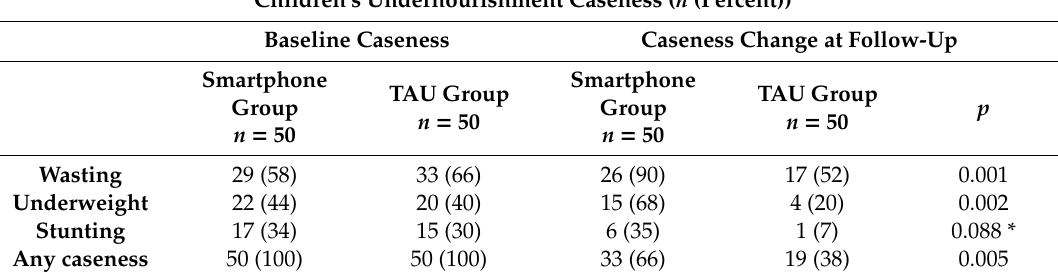
Table 5. Children’s undernourishment caseness (z-score < -2) at baseline measured as wasting (WHZ), underweight (WAZ), and stunting (HAZ), and caseness change at follow-up in smartphone and TAU groups ( n (percent)). p -values indicate di ff erence in caseness change between the study groups. Children’s Undernourishment Caseness ( n (Percent)) Baseline Caseness Caseness Change at Follow-Up Smartphone Smartphone TAU Group TAU Group p Group Group n = 50 n = 50 n = 50 n = 50 Wasting 29 (58) 33 (66) 26 (90) 17 (52) 0.001 Underweight 22 (44) 20 (40) 15 (68) 4 (20) 0.002 Stunting 17 (34) 15 (30) 6 (35) 1 (7) 0.088 * Any caseness 50 (100) 50 (100) 33 (66) 19 (38) 0.005 * Fisher’s exact test was